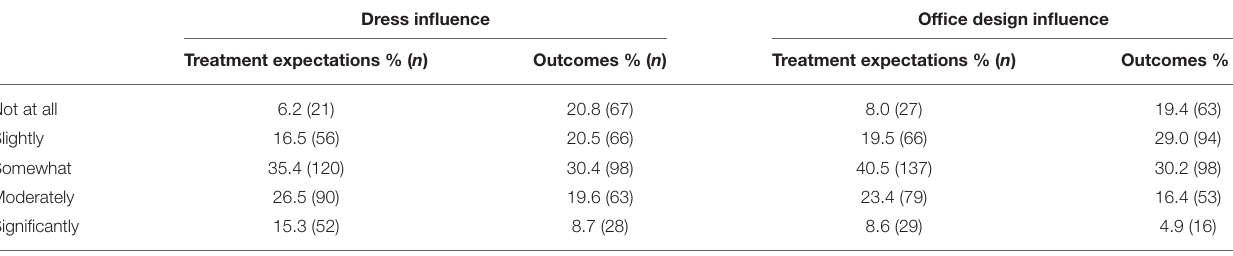
TABLE 4 | Influence of dress and office design on patient expectations and